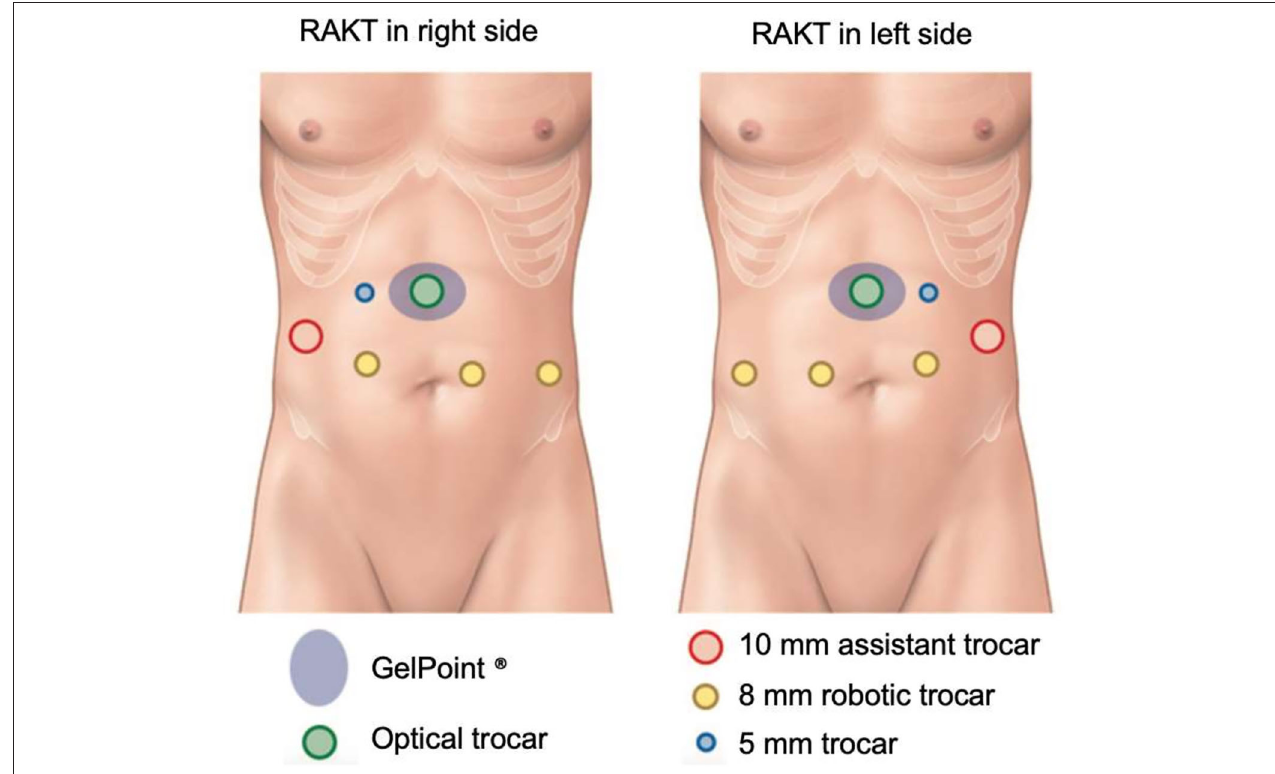
FIGURE 1 | RAKT trocar location. Adapted from Prudhomme et al.